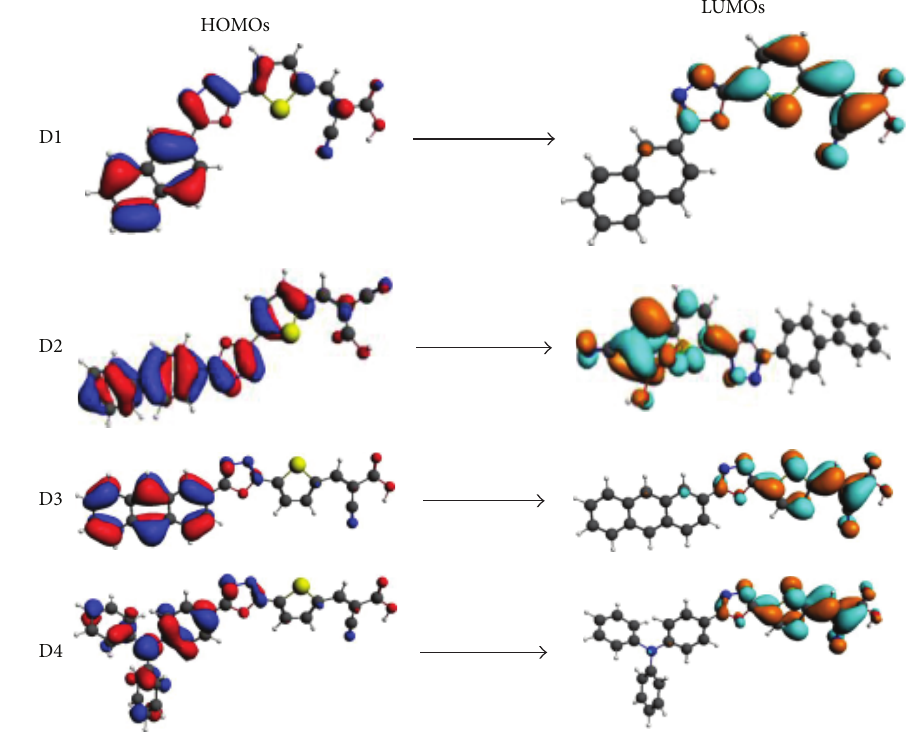
Figure 2: Simulated HOMOs and LUMOs of the dyes.